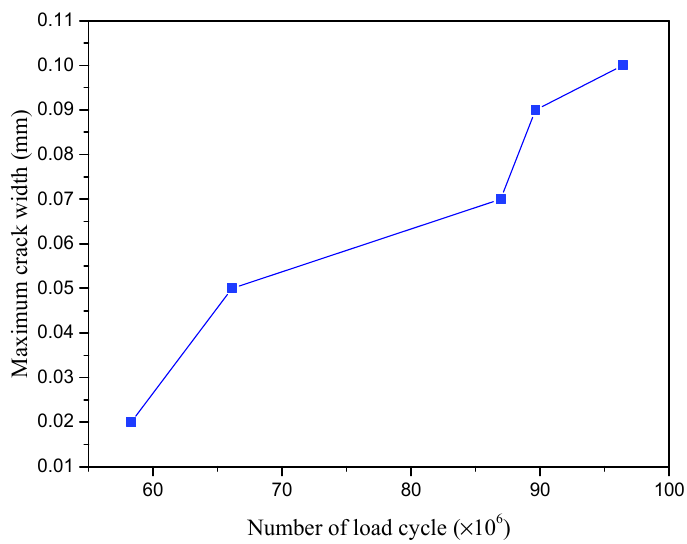
Figure 20. Maximum crack width- equivalent number of load cycle curve.